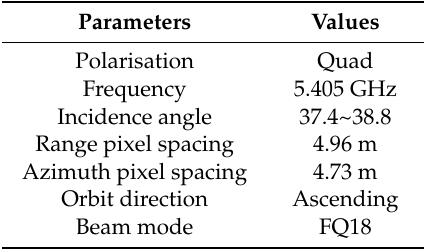
Table 1. The details of five Radarsat-2